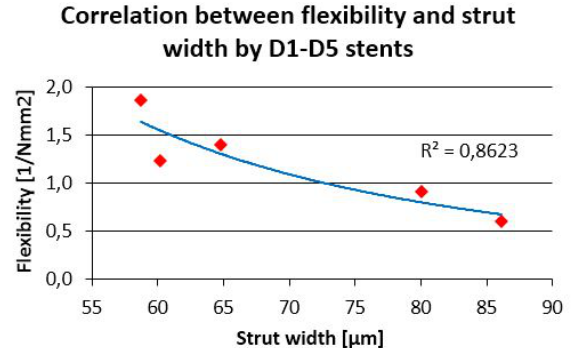
Figure 5. Correlation between flexibility and diame- ter in the case of stent-systems. Figure 6. Correlation between flexibility and strut width in the case of